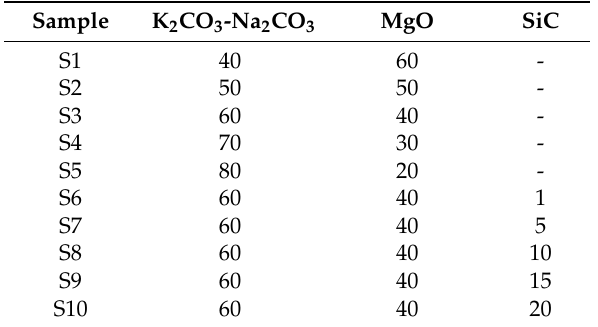
Table 2. Formulations of the K 2 CO 3 -Na 2 CO 3 /MgO/SiC composite PCMs (ratio in mass).